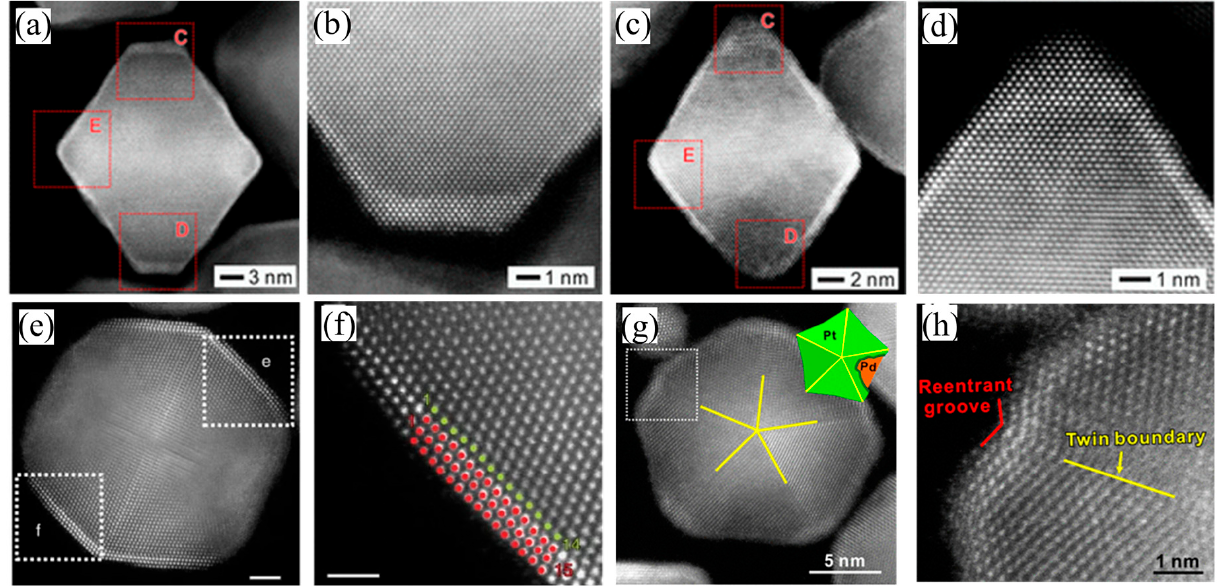
Figure 2. Structural analyses of the Pt/Pd bimetallic nanocrystals. ( a – d ) HAADF-STEM images of the Pd@Pt 2 − 3L octahedra synthesized using the polyol-based protocol and water, respectively. Reprinted with permission from Ref. [36]. Copyright 2015, ACS Nano. ( e , f ) Atomic-resolution HAADF-STEM images of Pd@Pt 2.7L icosahedra (green dots: Pd atoms; red dots: Pt atoms). Scale bar, 2 nm for ( e ) and 1nm for ( f ). Reprinted with permission from Ref. [37]. Copyright 2015, Nature Communications. ( g ) Atomic-resolution HAADF-STEM image and a model of the decahedron viewed along its 5-fold axis (inset). ( h ) Atomic-resolution AADF-STEM image taken from the corner marked by a box in ( g ), showing the presence of re-entrant groove at a vertex and twin boundary along a ridge. Reprinted with permission from Ref. [38]. Copyright 2015, Journal of the American Chemical Society.